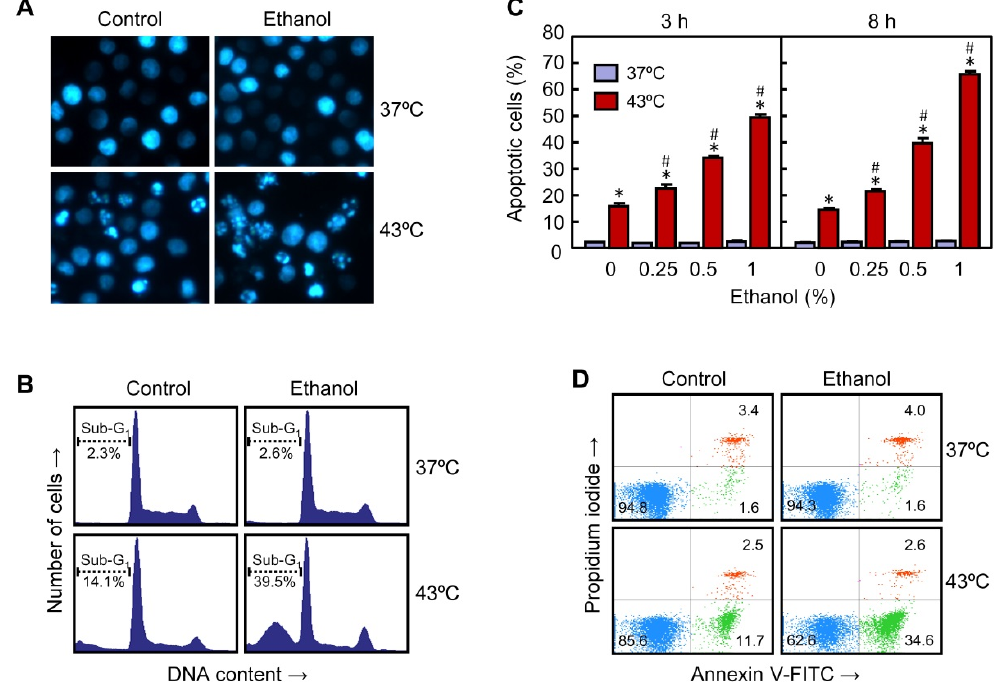
Figure 2. Effect of ethanol on apoptotic cell death in U937 cells subjected to hyperthermia. ( A ) The cells were pre-incubated in absence or presence of 0.5% ethanol for 30 min, exposed to hyperthermia (30 min at 43 ◦ C) and allowed to recover for 24 h. The cells were collected, stained with bisbenzimide trihydrochloride and nuclei visualized by fluorescent microscopy; photomicrographs of representative fields of cells to evaluate nuclear chromatin condensation (i.e., apoptosis) are shown. Magnification 40 × . ( B ) The cells were pre-incubated in absence or presence of 0.5% ethanol for 30 min, exposed to hyperthermia (30 min at 43 ◦ C) and allowed to recover for 8 h. The cells were harvested and cell distribution, according to their DNA content, was determined by flow cytometry using the propidium iodide staining procedure; the position of cells with sub-G1 DNA content (i.e., apoptotic cells) is indicated by a dotted line. Representative histograms are shown. ( C ) The cells were pre-incubated in absence or presence of the indicated concentrations of ethanol and allowed to recover for the indicated period of time. The cells were collected, and the percentage of apoptotic cells was determined by flow cytometry as above. ( D ) The cells were pre-incubated in absence or presence of 0.5% ethanol for 30 min, exposed to hyperthermia (30 min at 43 ◦ C) and allowed to recover for 3 h. The cells were collected, stained with propidium iodide and annexin V-FITC and analyzed by flow cytometry. * p < 0.05 vs. respective control at 37 ◦ C; # p < 0.05 vs. hyperthermia (43 ◦ C) treatment